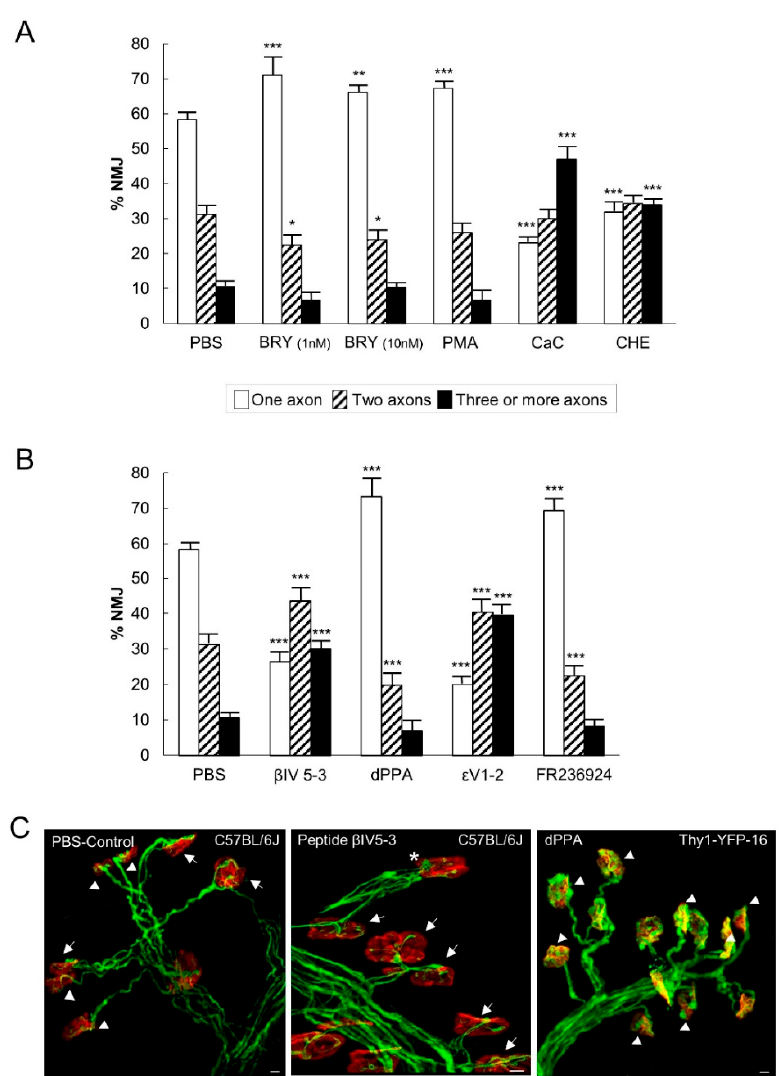
Figure 4. PKC activity modulation in axonal loss. ( A ) shows the percentage of singly-, doubly-, and triply- (or more) innervated NMJs in the control mice (PBS) and after four applications of one of the following substances: the PKC paninhibitors Chelerytrine (CHE) and CaC, and the PKC panstimulators (BRY, at 1 and 10 nM) and PMA. CHE and CaC action results in the persistence of many polyinnervated synapses. Accordingly, both PKC stimulators PMA and BRY increase the number of monoinnervated junctions and clearly decrease the percentage of doubly-innervated junctions in the case of BRY. ( B ) shows the percentage of singly-, doubly-, and triply (or more) innervated NMJs after exposure to the cPKC β I and nPKC ε isoform selective inhibitors β IV 5–3 and ε V 1–2 , and the cPKC β I and nPKC ε selective activators dPPA and FR 236,924 respectively. The selective inhibitors similarly increase the doubly- and triply-innervated synapses with the corresponding reduction in the monoinnervated junctions. The activators considerably accelerate nerve terminal elimination. Data were presented as percentages of NMJ ± SD (for each treatment and PBS control: n pups = 6–9; n = 11–18 LALs; n NMJ: PBS: 2538; Bry 1 nM: 1232 Bry 10 nM:1384; PMA:1247; CaC: 1573; Che:1499; β IV 5–3 : 1275; dPPA: 1121; ε V 1–2 :1663 and FR 236924: 1367). Fisher’s test: * p < 0.05, ** p < 0.01, *** p < 0.005. The confocal images in ( C ) (control PBS, arrow heads in monoinnervated junctions and arrows in multiinnervated NMJ), show that the application of the inhibitor peptide β IV 5–3 increases the number of multiinnervated NMJ (center, arrows) junctions, whereas the cPKC β I stimulator dPPA (but also the nPKC ε selective activators FR 236924, not shown here) increases the number of monoinnervated junctions (right, arrow heads).